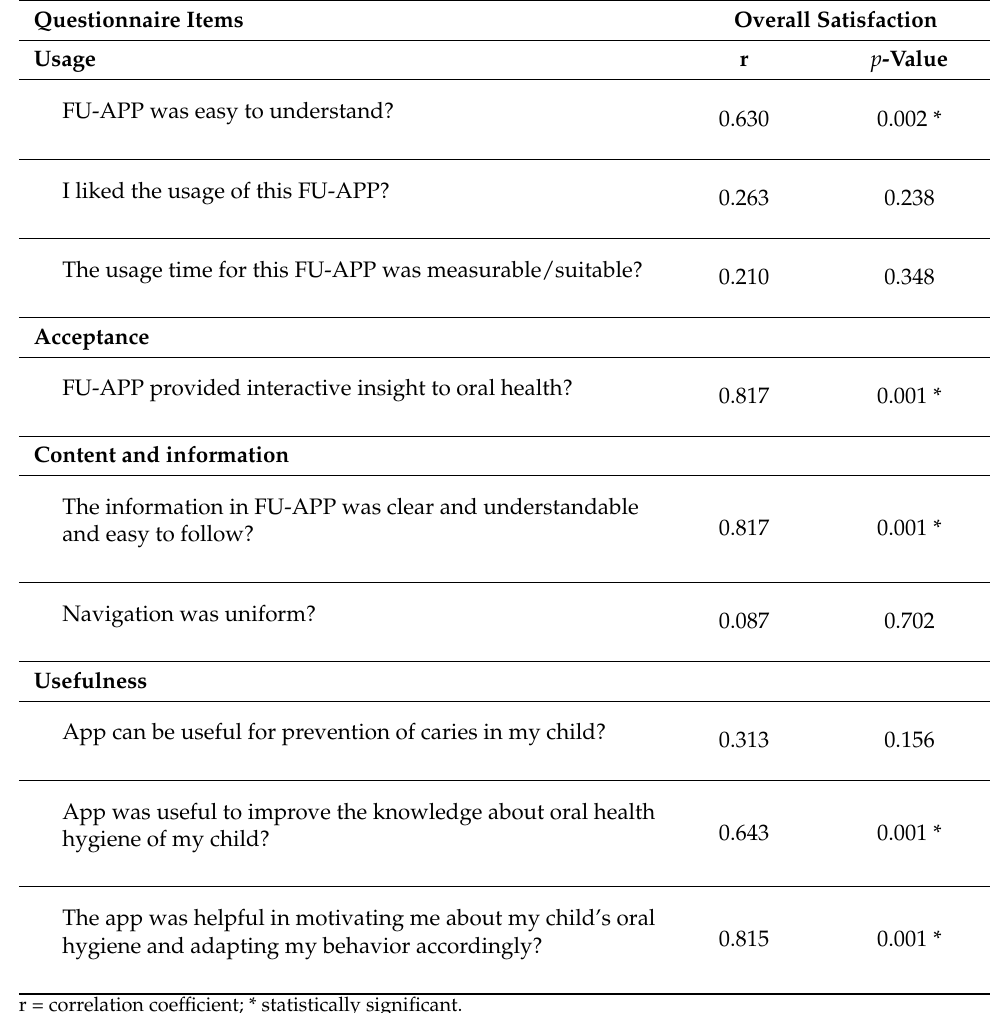
Table 1. Correlations between parental overall satisfaction and baseline